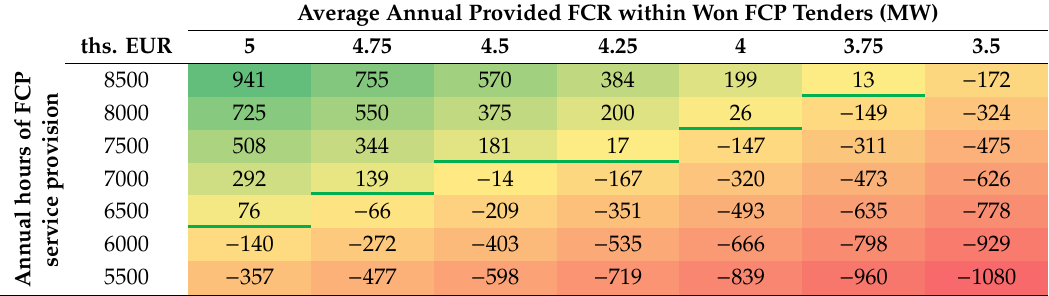
Table 11. Sensitivity analysis of the FCR power reserve and number of hours successful in the